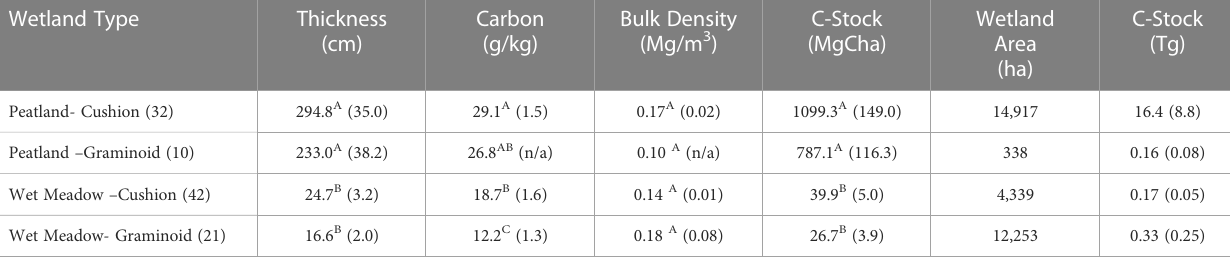
TABLE 1 Wetland soil properties, area (Chimner et al., 2019), and total carbon stocks (standard errors in parenthesis). Wetland